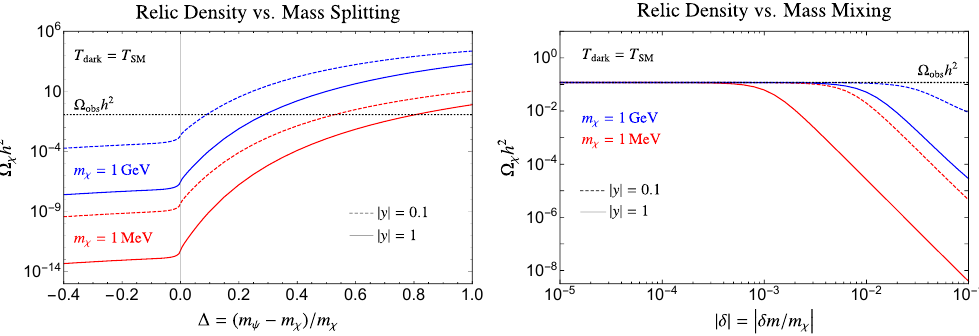
Figure 6 . Left : dependence of the relic density on the mass splitting (cid:1) between DM, (cid:31) , and its rapidly annihilating